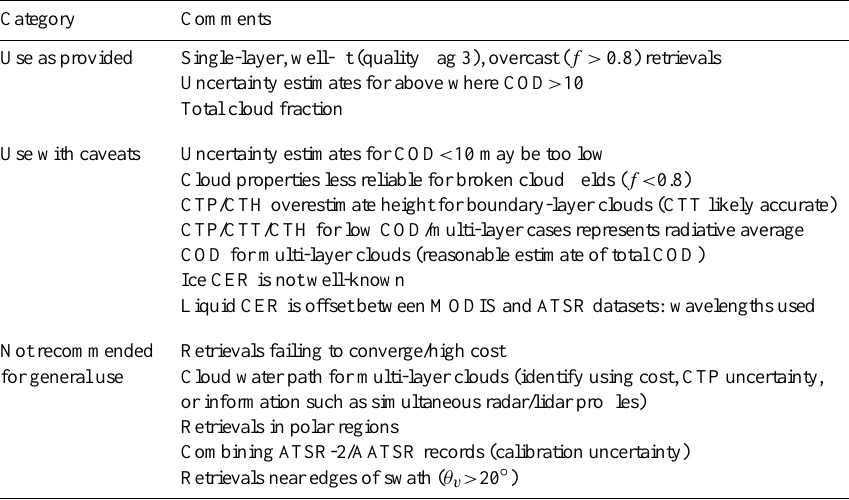
Table 7. Summary of recommendations for use of GRAPE cloud